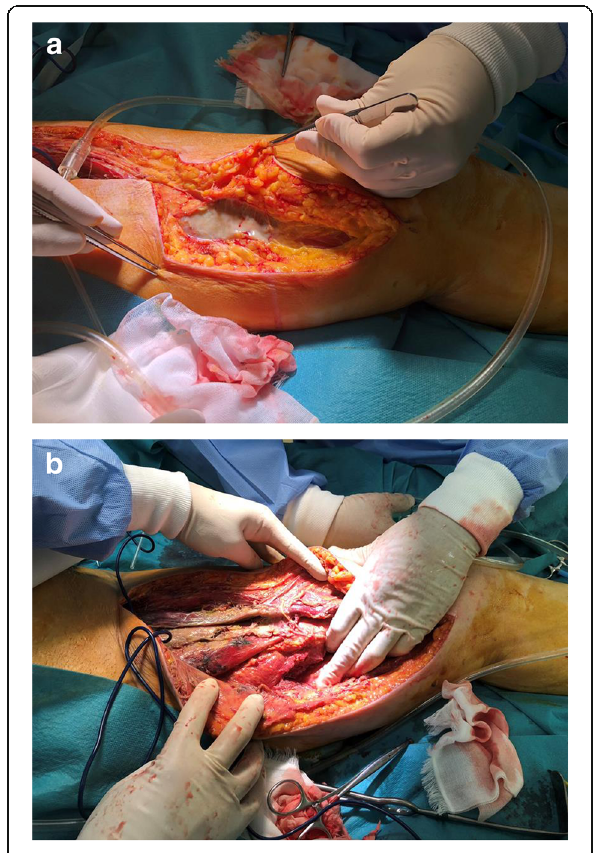
Fig. 3 a , b Additional extensive open wound for drainage from the initial drainage site of the left thigh (Fig. 2a) to the level of the left knee was performed on day 1 after